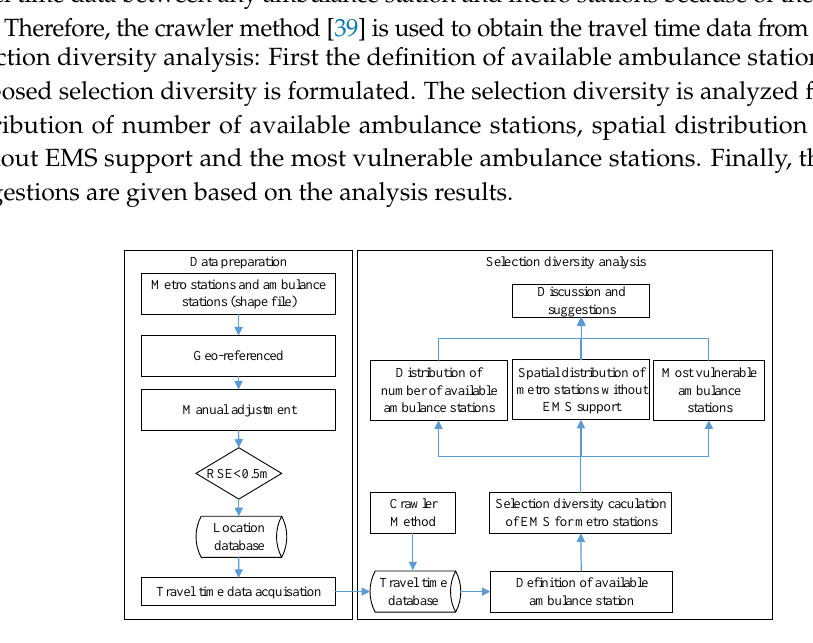
Figure 1. Framework of